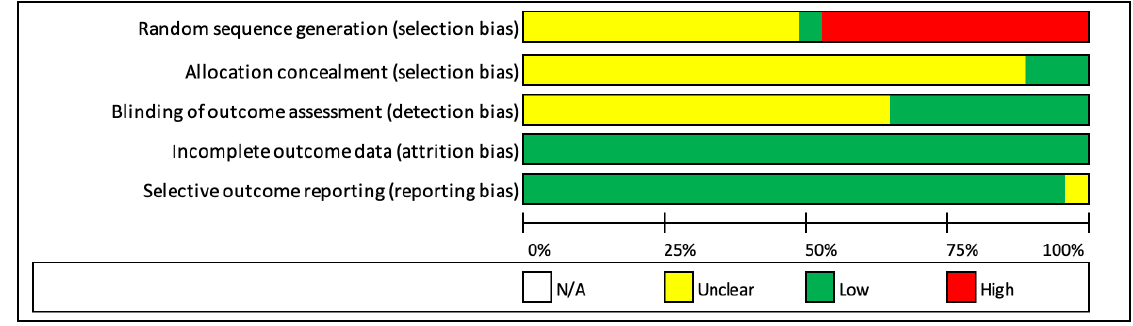
Table 2. Testing parameter of in vitro studies (Note: All loads converted to newtons 1 kg = 9.81 N; 1 pound = 4.448 N).